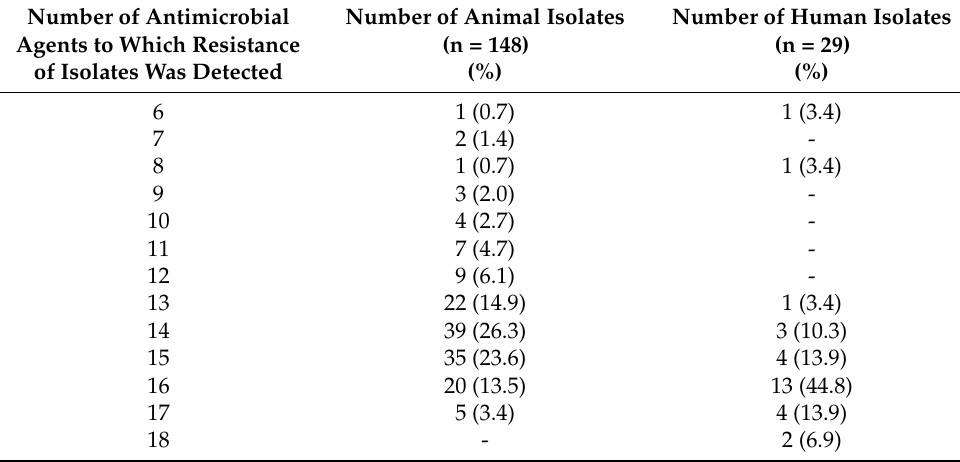
Table 4. Resistotypes found among 148 animal and 29 human Francisella tularensis subsp. holarctica isolates according to the number of antimicrobial agents to which they showed resistance. Number of Human Isolates Number of Animal Isolates Number of Antimicrobial (n = (n = 148) Agents to Which Resistance (%) of Isolates Was Detected